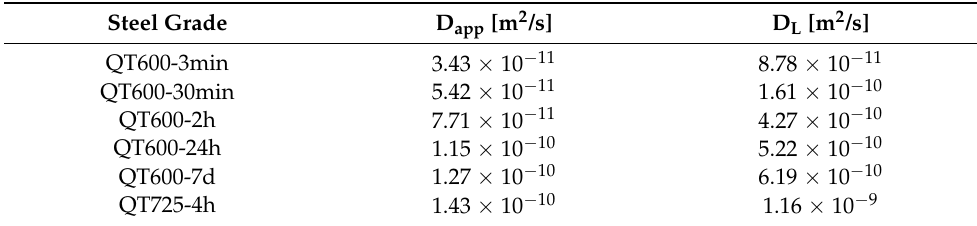
Table 6. D app (first transient) and D L of quenched and tempered 42CrMo4 grades.